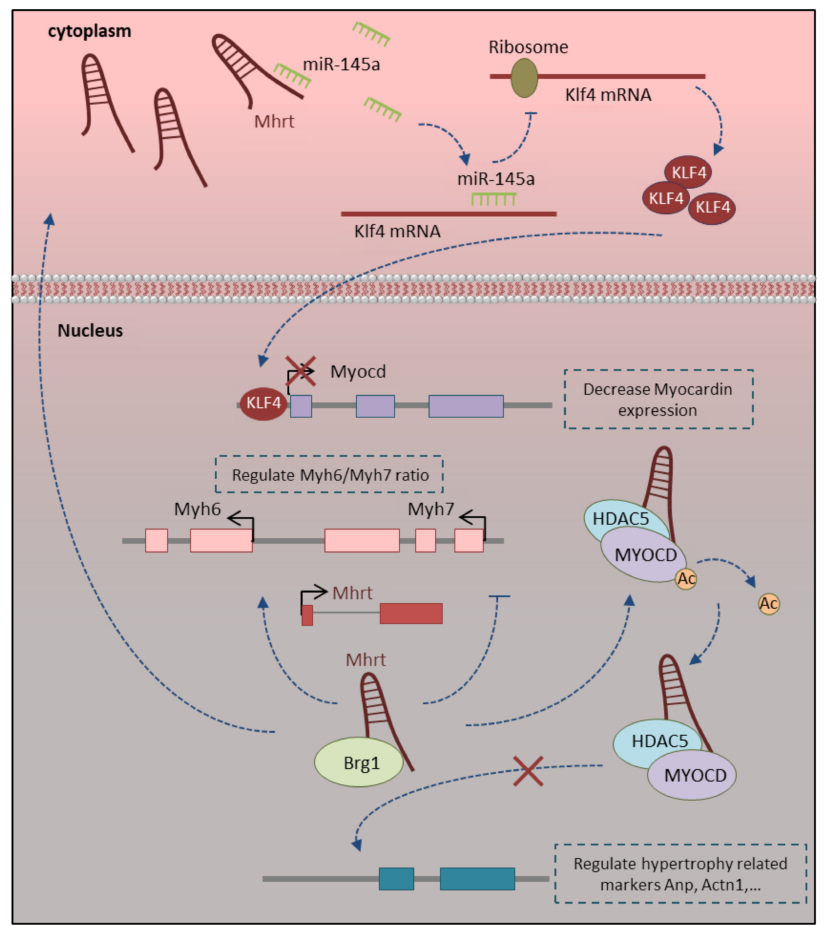
Figure 3. Roles of Mhrt-LncRNA in cardiomyocyte maturation. Mhrt-lncRNA has a different regulatory function in myofibril formation and hypertrophy at the stage of cardiomyocyte maturation. Mhrt regulates the Myh6/Myh7 ratio and their expression during the development through Brg1 inhibition. Cardiomyocyte hypertrophy regulation is also occurred by Mhrt through myocardin expression and function regulation. More details are described within the